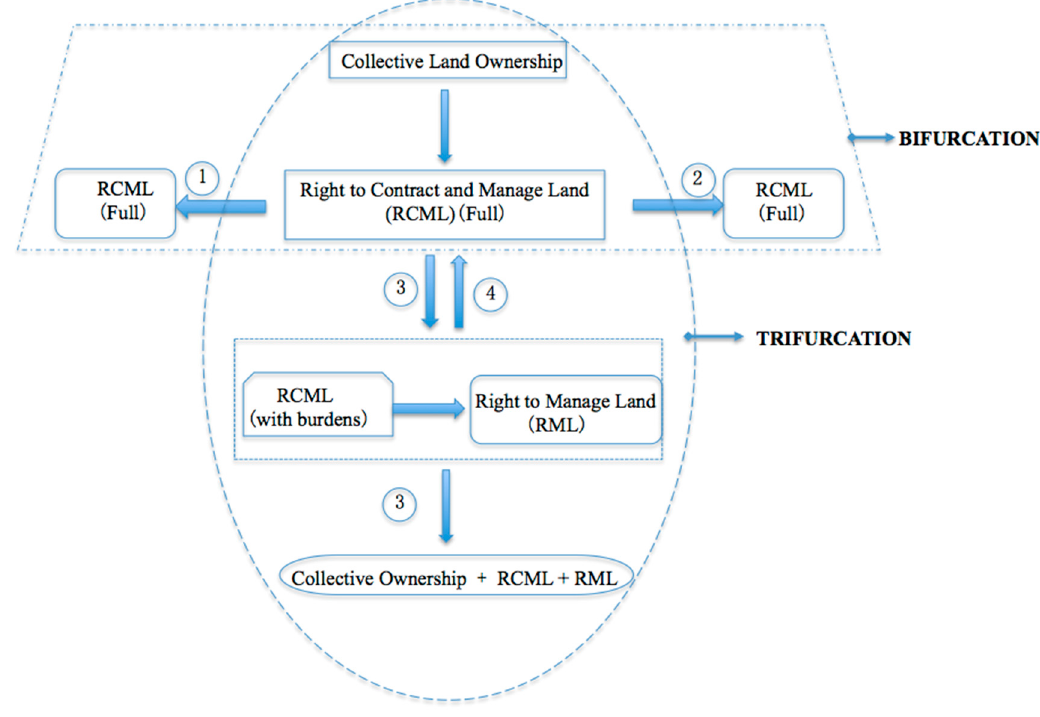
Figure 5. The trifurcation structure of rights on contracted farmland and relations among them.